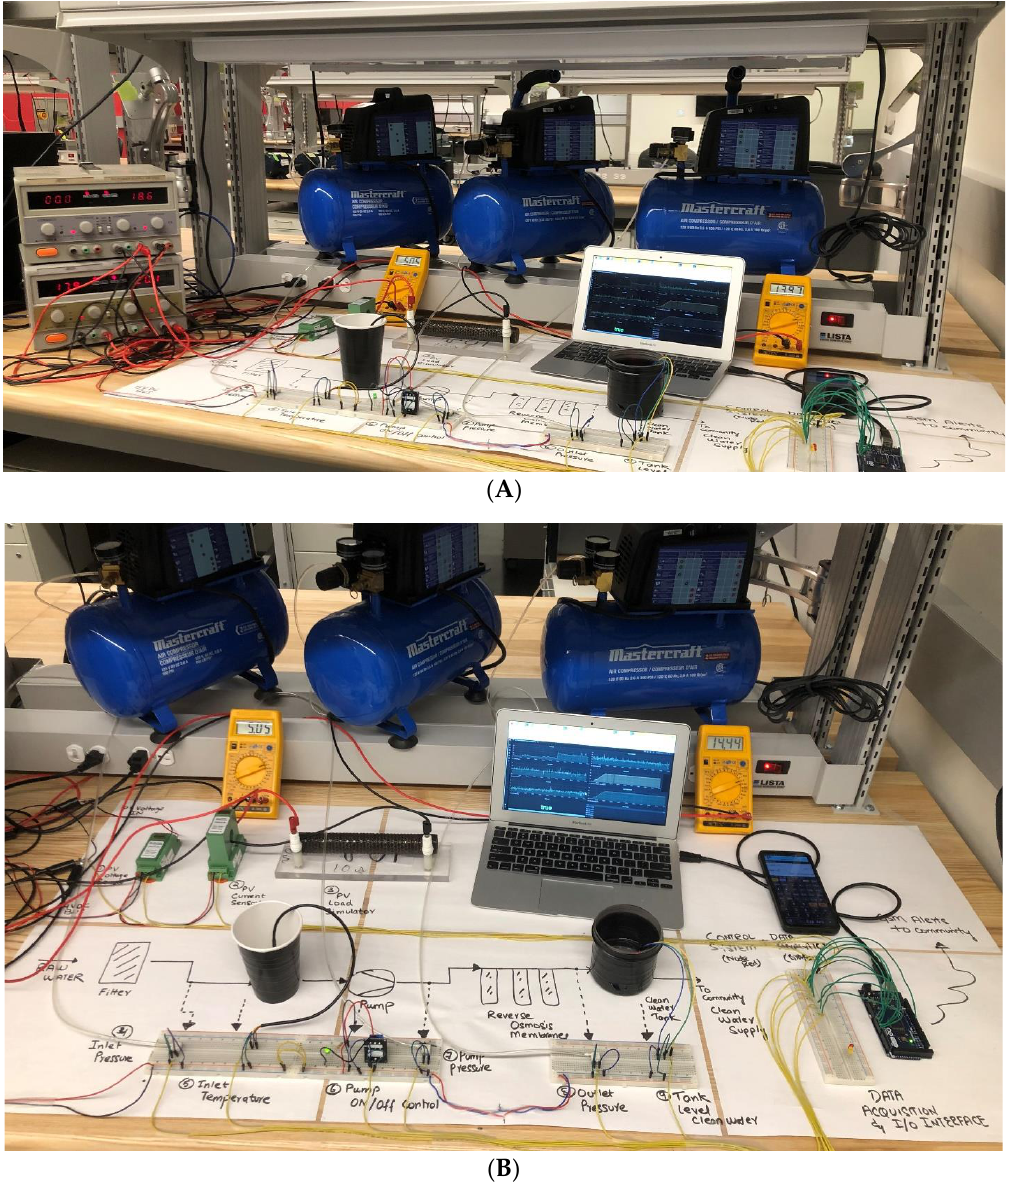
Figure 9. ( A ) Experimental setup of the system (Front View). ( B ) Experimental setup of the system (Top View).